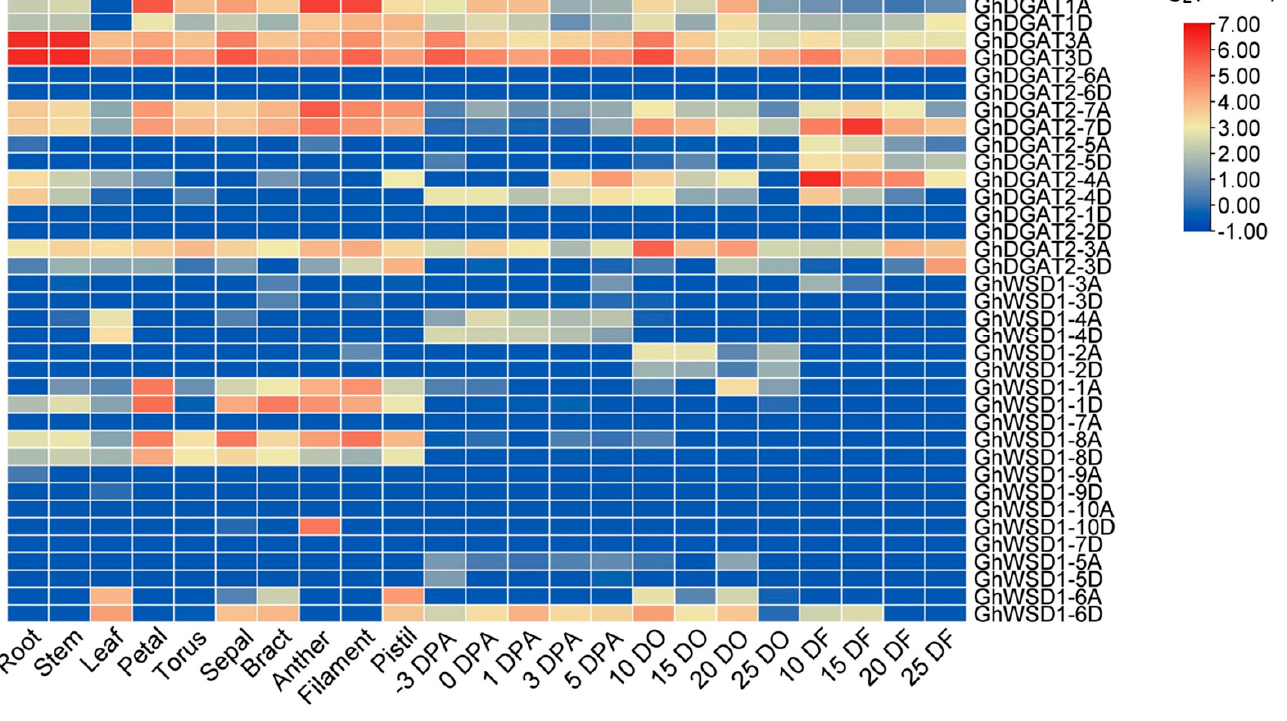
Figure 8. Expression patterns of GhDGAT and GhWSD1 genes in upland cotton. DF: DPA fiber; DO: DPA ovule. Gene expression levels (FPKM) were averaged and normalized by a log2 scale.